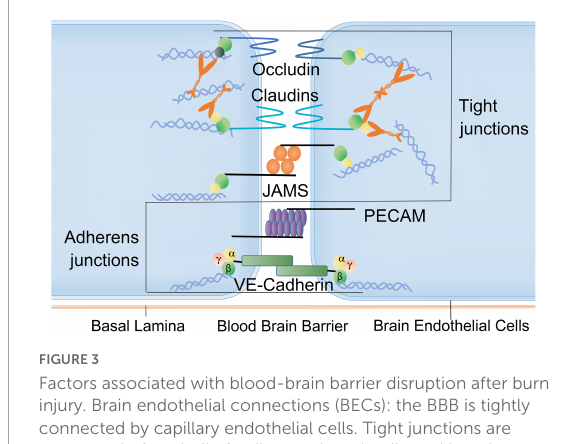
FIGURE3 Factors associated with blood-brain barrier disruption after burn injury. Brain endothelial connections (BECs): the BBB is tightly connected by capillary endothelial cells. Tight junctions are composed of occludin family proteins, claudin and junction adhesion molecules (JAMs). The connections between endothelial cells also include adhesion junctions consisting of platelet endothelial cell adhesion molecules (PECAMs) and VE-cadherin. These structures and molecules can be damaged following burn injury. JAMs, junction adhesion molecules; PECAMs, platelet endothelial cell adhesion